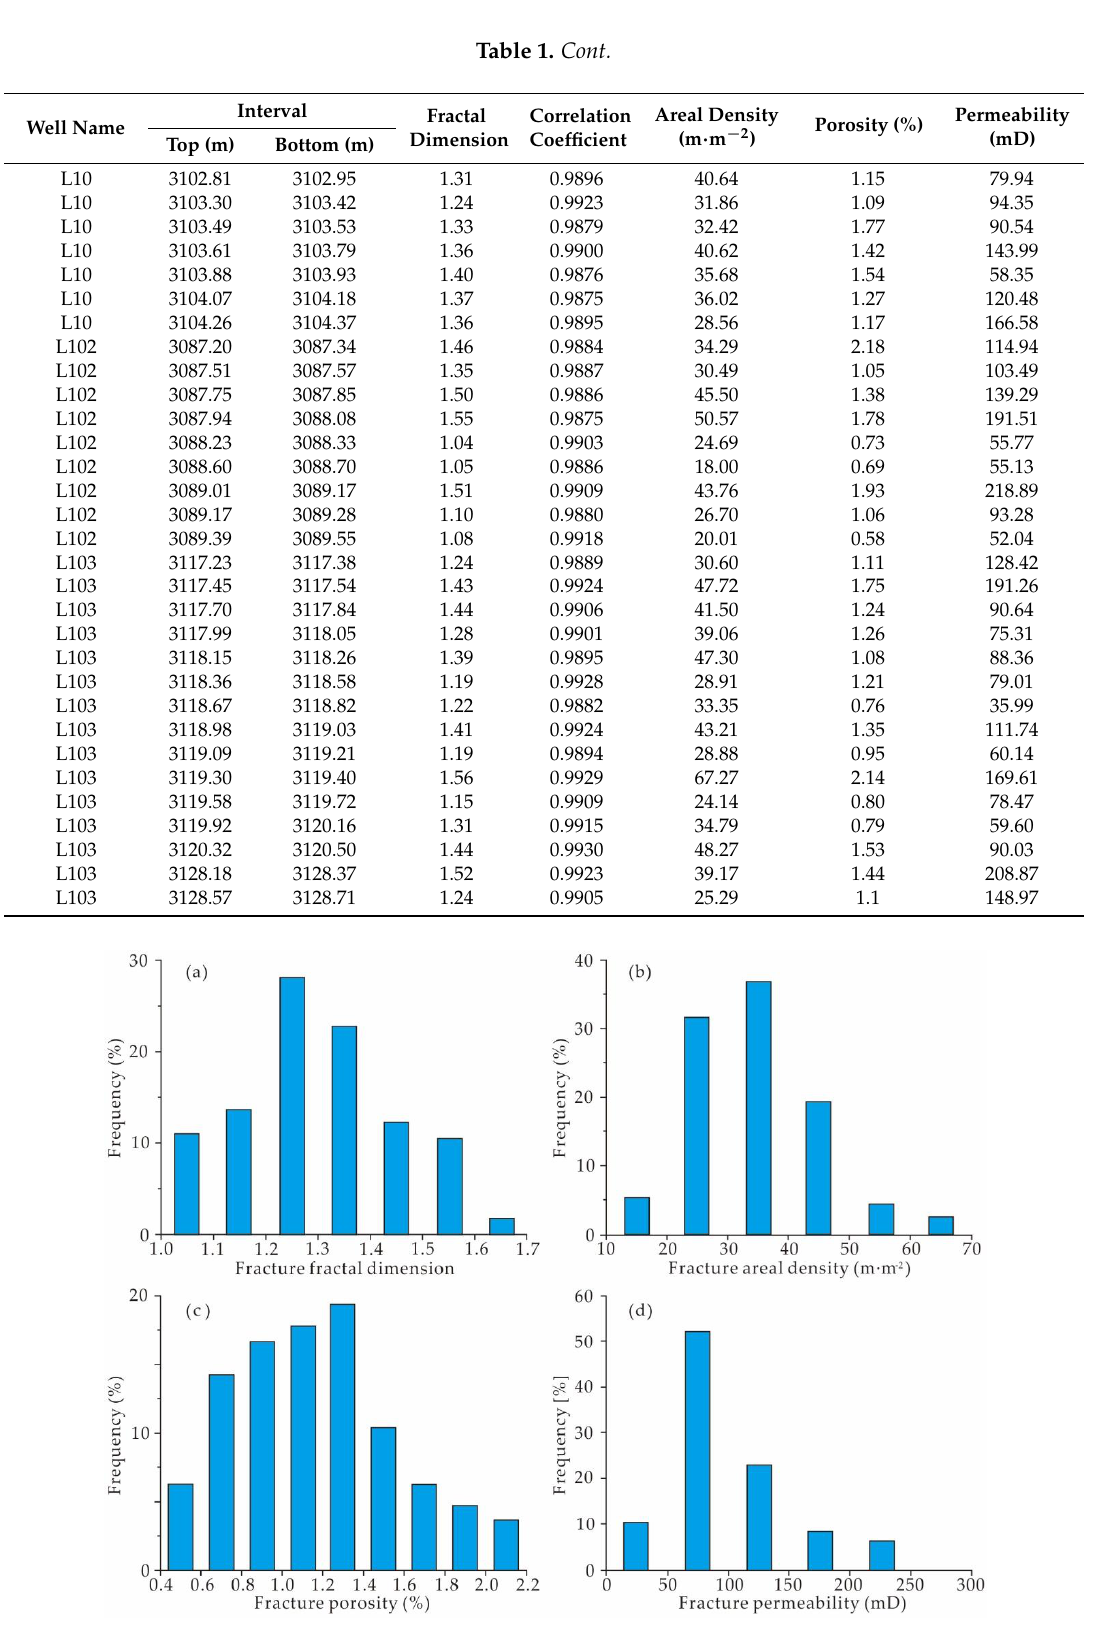
Figure 7. Distributions of fracture parameters. ( a ) Distribution of fracture fractal dimension; ( b ) distribution of fracture areal density; ( c ) distribution of fracture porosity; ( d ) distribution of fracture